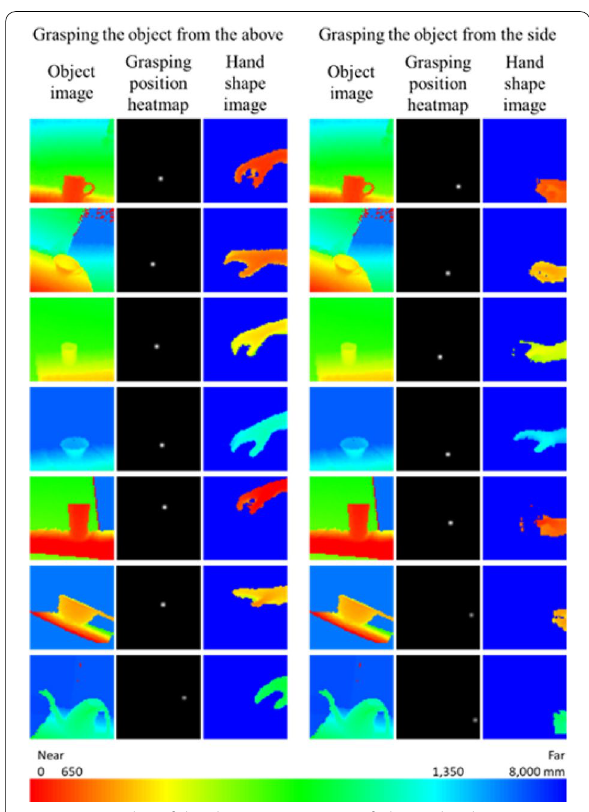
Fig. 7 Examples of the dataset consisting of object depth images, grasping position heatmaps and depth images of the grasping hand shape. Each row demonstrates examples of the different grasping methods for the same object image. The object and hand shape image are displayed by a colormap for the visibility of the